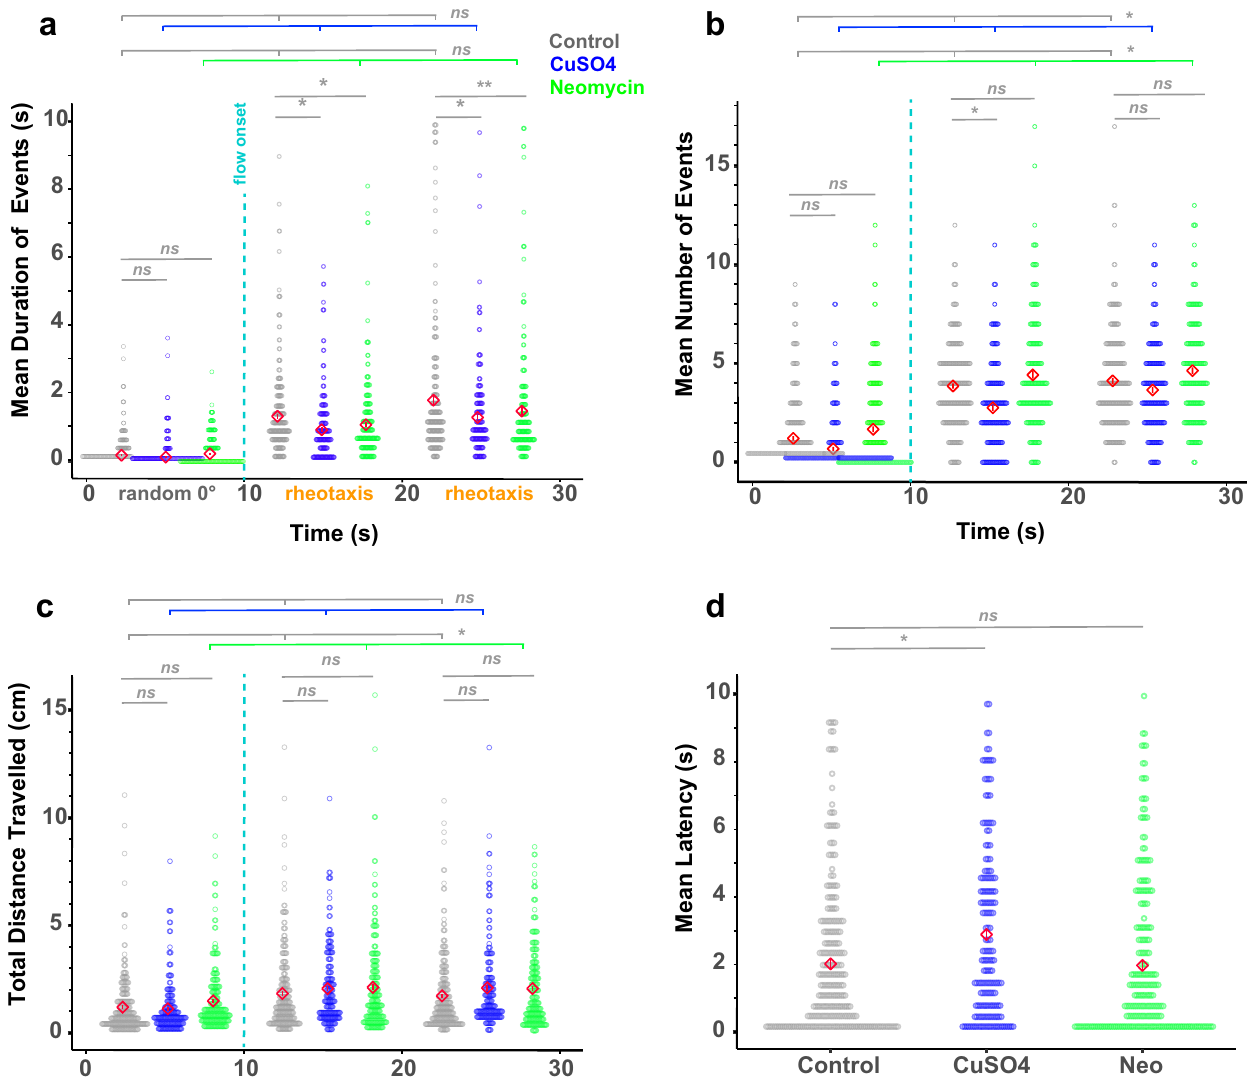
Fig. 4 Lateral line ablated fi sh performed rheotaxis for shorter mean durations yet traveled greater total distances compared to controls. Red diamonds in each plot indicate the mean ± SE values. a Lateral line intact fi sh (gray = control, n = 248 fi sh) have a longer mean duration of rheotaxis events during fl ow stimulus than lesioned fi sh (blue = CuSO 4 , n = 204 fi sh; green = neomycin, n = 222 fi sh; 18 experimental sessions). b The mean number of 0° orientation and rheotaxis events was greatest for neomycin fi sh and the least for CuSO 4 fi sh under no fl ow and fl ow conditions, respectively. c Under no fl ow, neomycin fi sh traveled a greater total distance than control and CuSO 4 fi sh; but under fl ow, neomycin and CuSO 4 fi sh traveled a greater total distance than control fi sh. d Compared to control and neomycin fi sh, CuSO 4 fi sh had the longest mean latency to the onset of the fi rst rheotaxis event after fl ow stimulus presentation. Lines indicate statistical comparisons between control and treatment groups (see Supplementary Tables 4 – 7). The effects of treatment are indicated by long color-coded bars with branches, whereas interactions are indicated with short bars. Signi fi cance values: * = 0.05, ** =